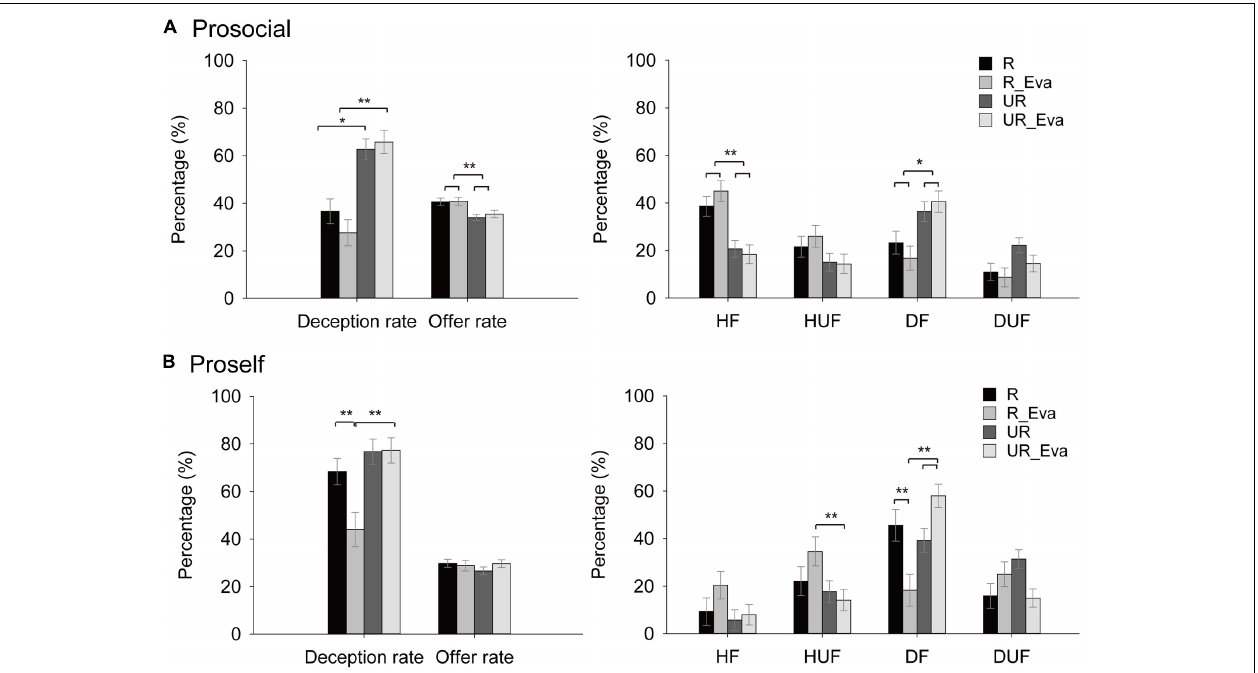
FIGURE 3 | Results in Experiment 2. (A) Prosocials’ deception rate, offer rate, and type of offers across conditions, which suggest that prosocials were sensitive to deception revelation rather than evaluation. (B) Proselfs’ deception rate, offer rate, and type of offers across conditions, which indicate that proselfs were more sensitive to evaluation, and decreased deception in moral hypocrisy when they faced both deception revelation and evaluation ( ∗∗ p < 0.01, ∗ p < 0.05).